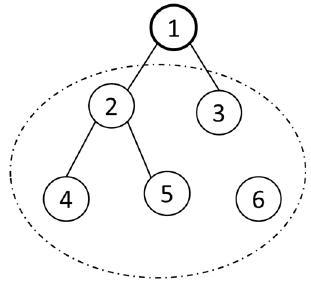
Figure 8. Parent choice example.